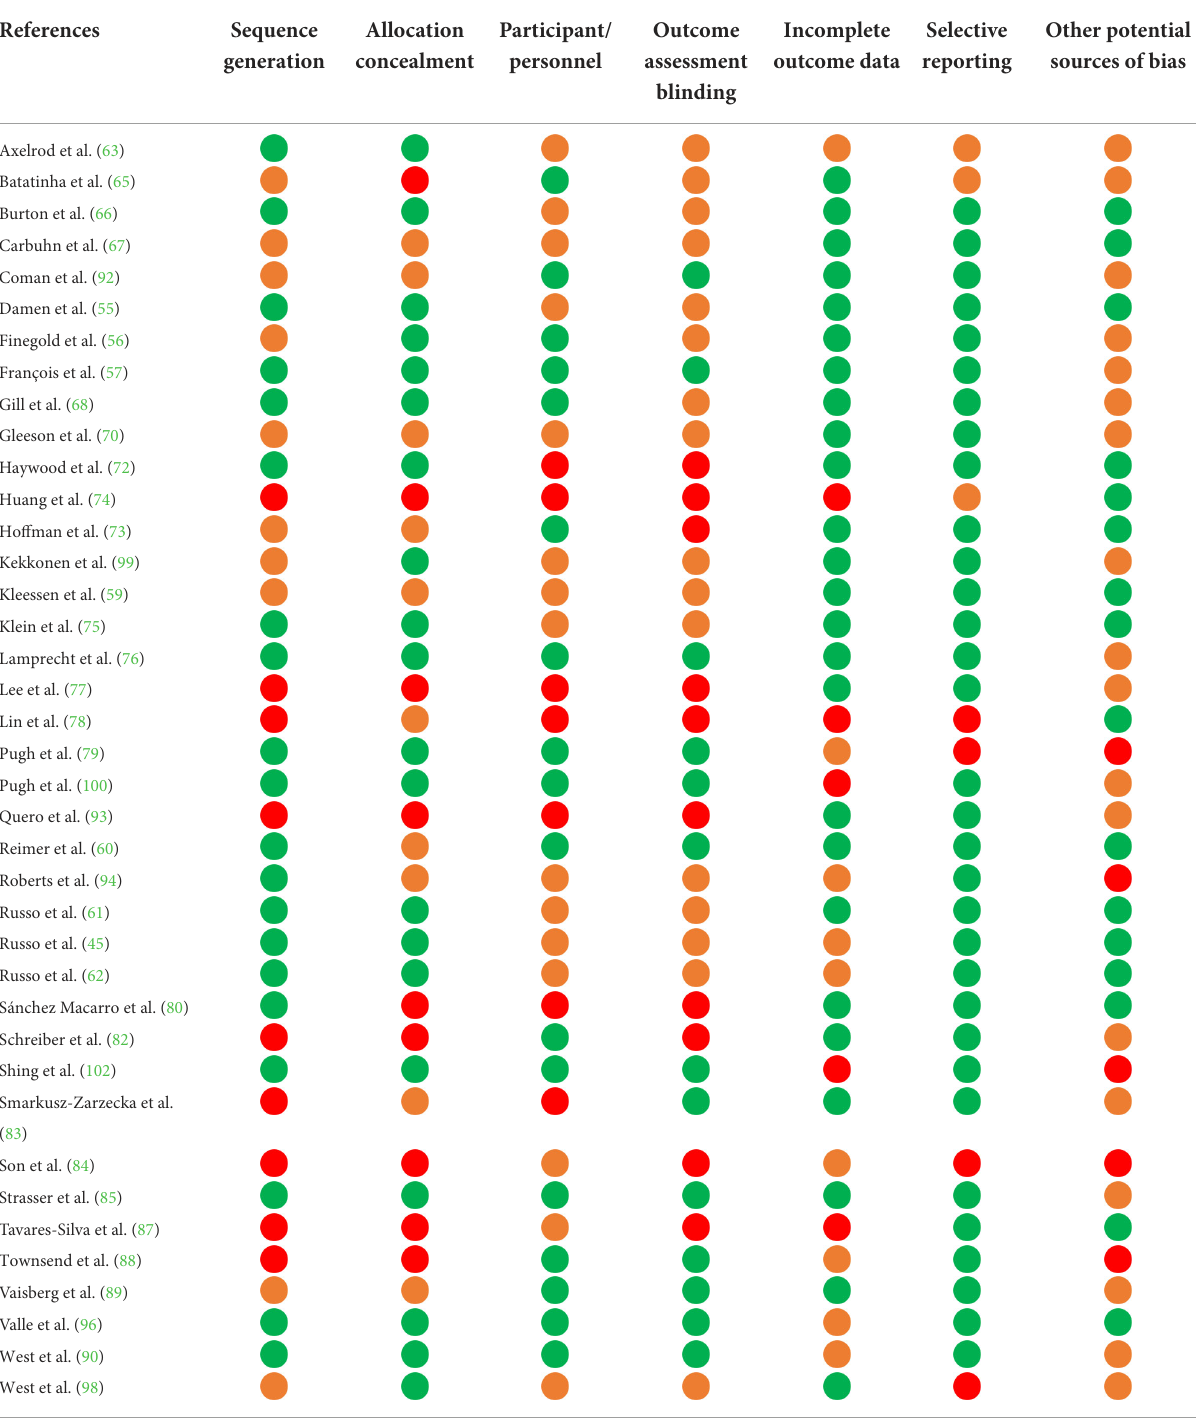
TABLE 7 Risk of bias